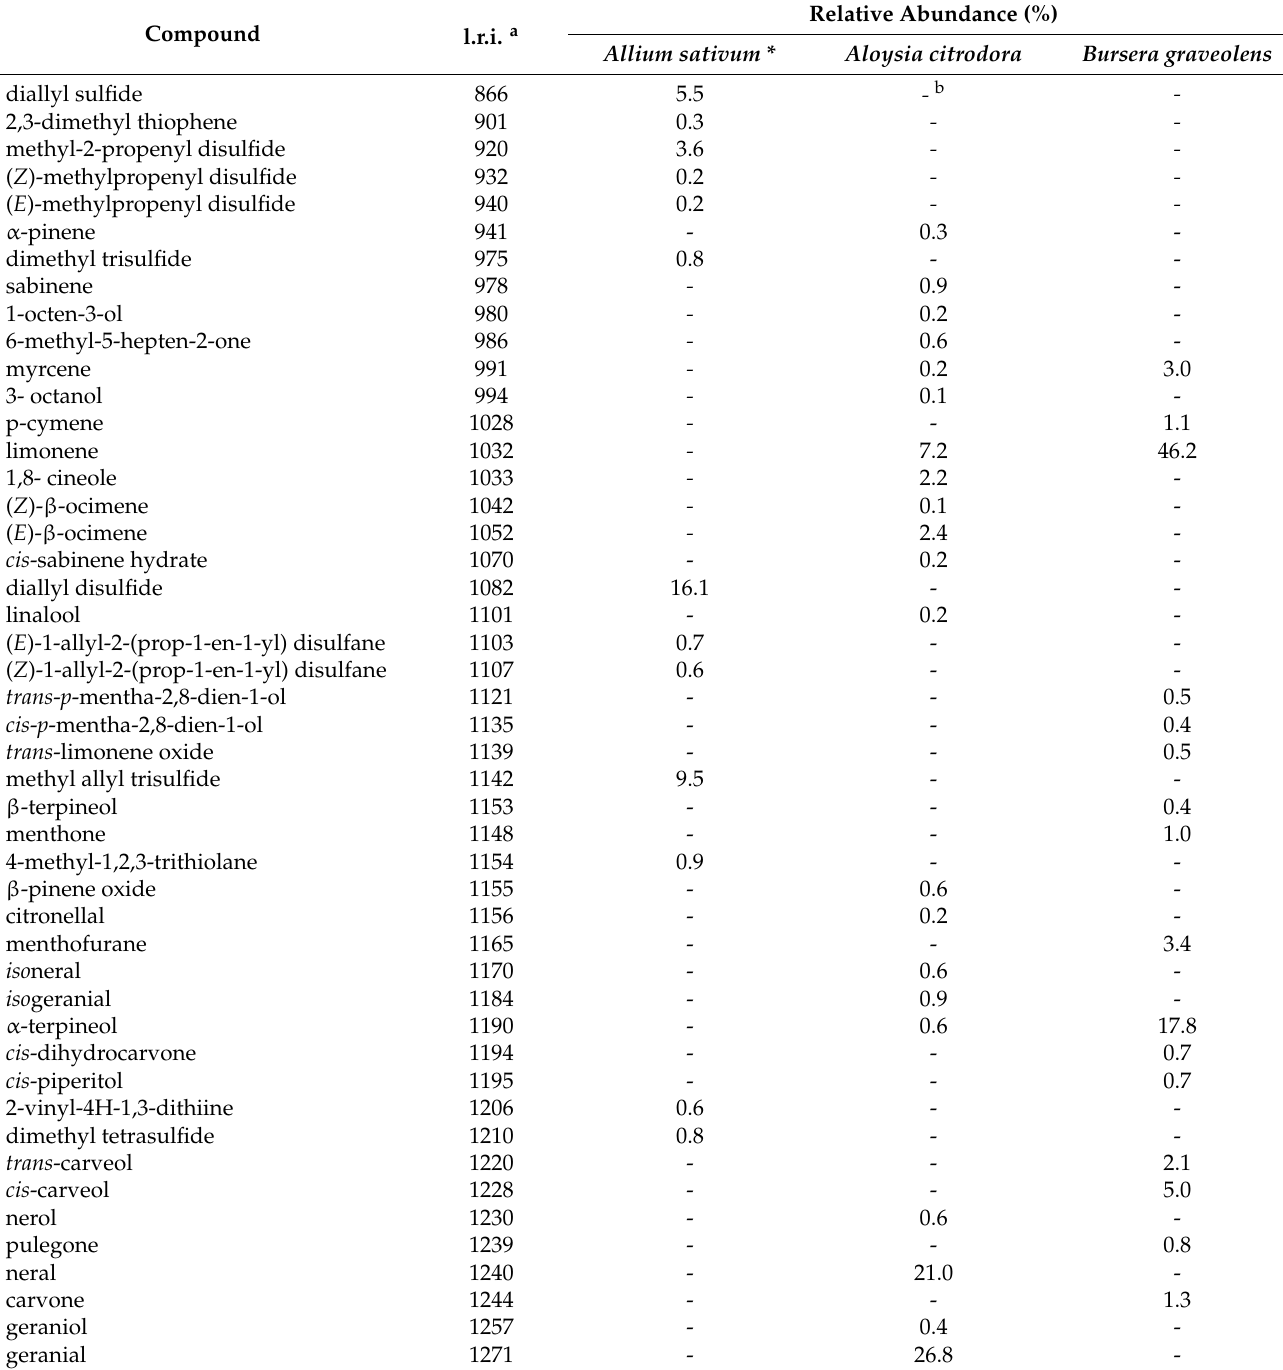
Table 1. Chemical compositions of Allium sativum , Aloysia citrodora , and Bursera graveolens essential oils